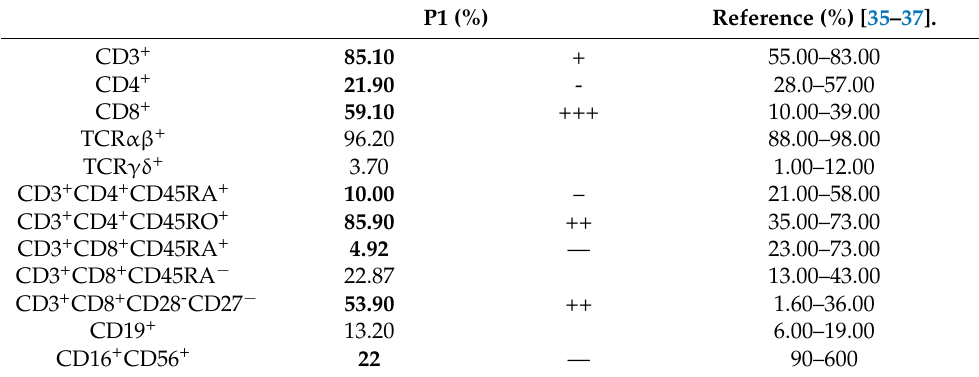
Table 3. Sur0r cells.